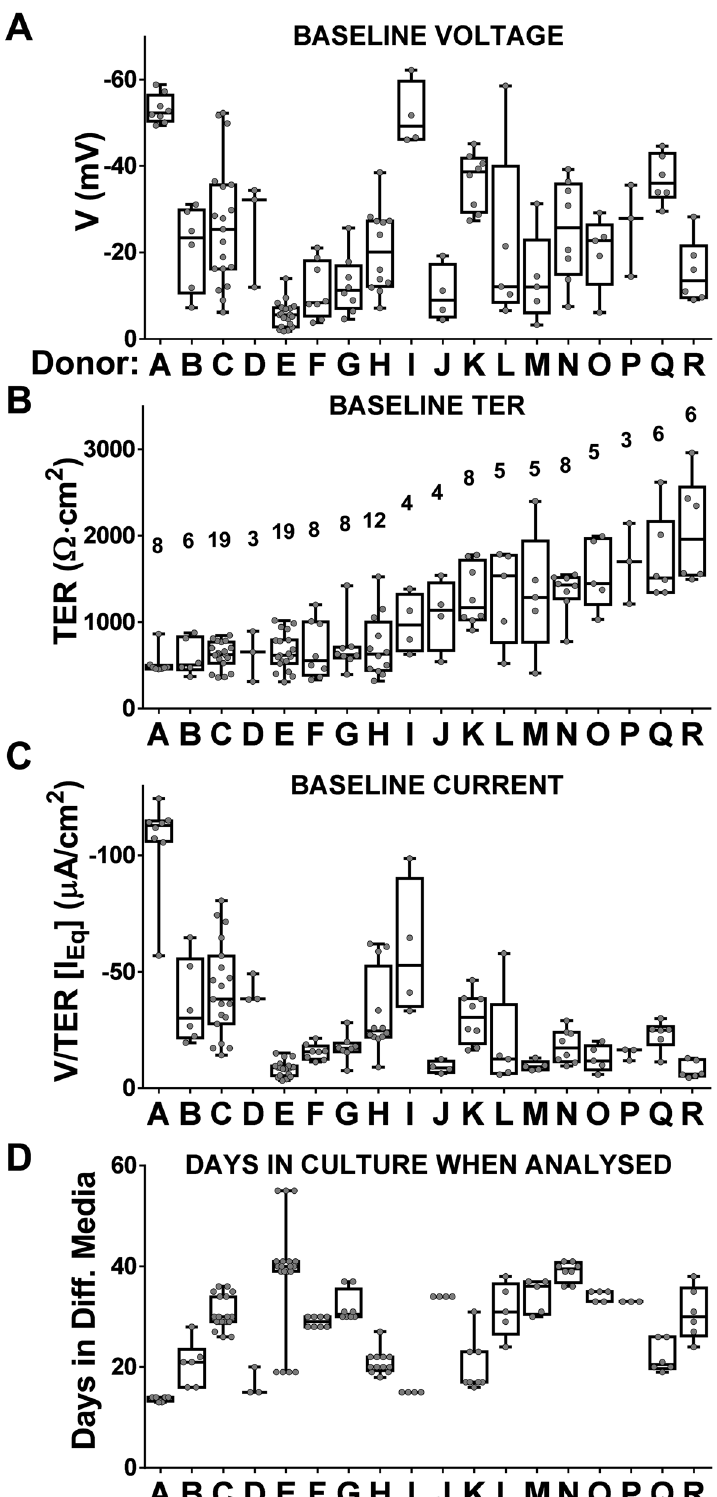
Fig 3. Electrophysiological values on an individual donor basis (A-R). Box plots per donor highlighting minimum, maximum (whiskers) and 25 th /75 th percentile and median (box). Donors arranged in ascending order ranked by mean values of TER in (B) with number of ALIs per donor above the boxes. These are compared with either (A) voltage, (C) [I eq ] and (D) time at ALI.